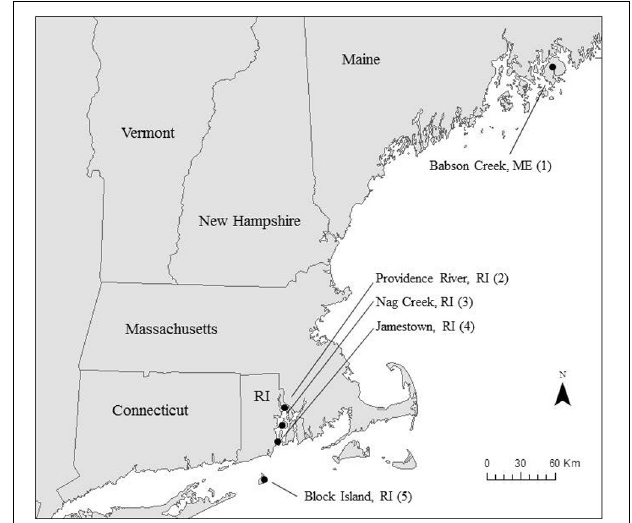
FIGURE 1 | Map of study region in New England,